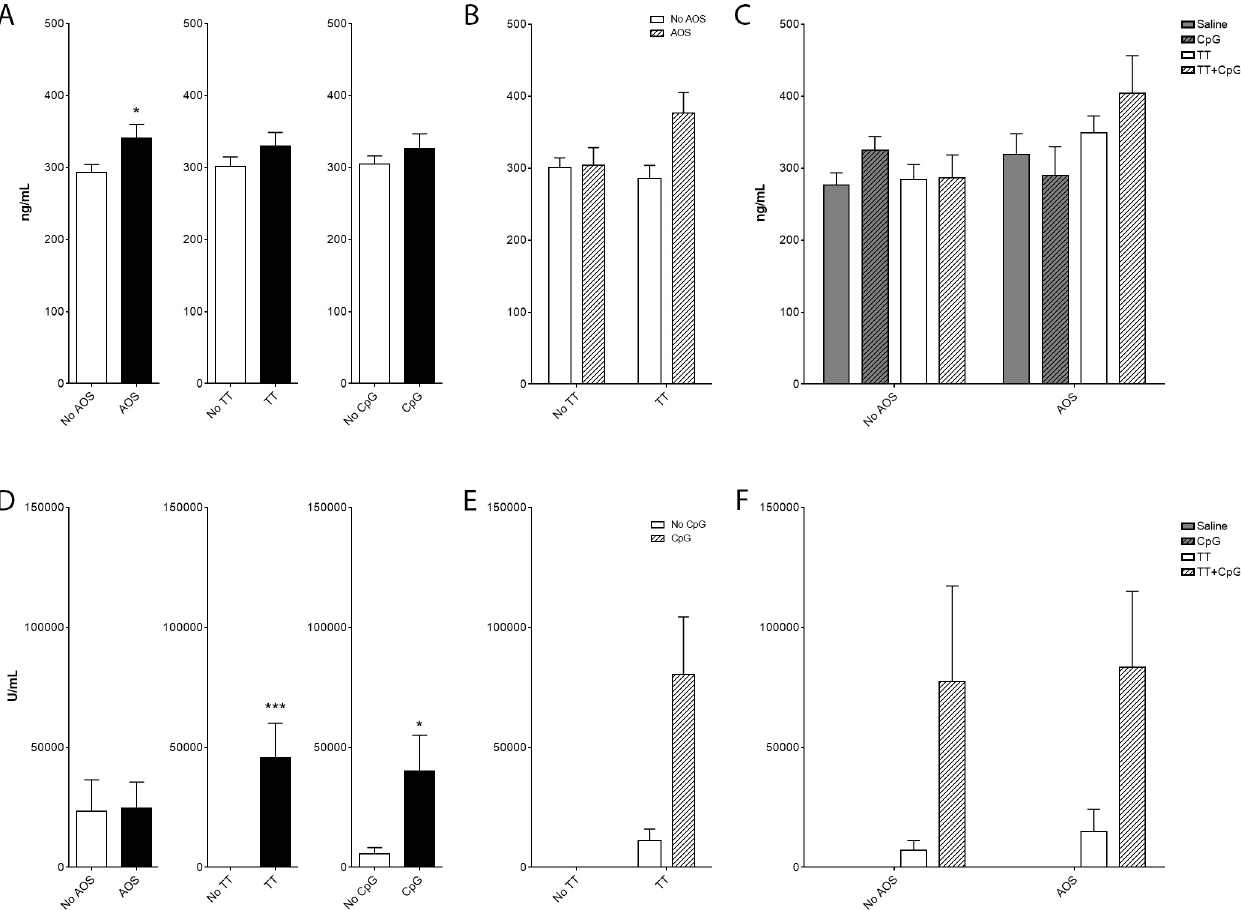
Fig 1. Impact of AOS, tetanus toxoid, and CpG on serum corticosterone and tetanus toxoid-specific IgG concentrations. Mice subjected to one or more treatment variables: by main effect (A), AOSxTT (B) and saline, CpG, TT, and CpG+T (C). Anti-TT serum IgG concentrations by main effect (D), TTxCpG (E), and saline, CpG, TT, and CpG+TT (F). Values represent mean ± SEM. N = 3–5 mice/group. � = P < 0.05, �� = P < 0.01, ��� = P < 0.001.